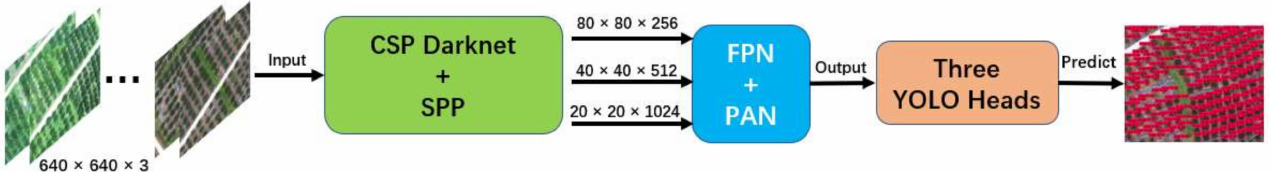
Figure 8. Flowchart of citrus tree target detection based on YOLOv5s.